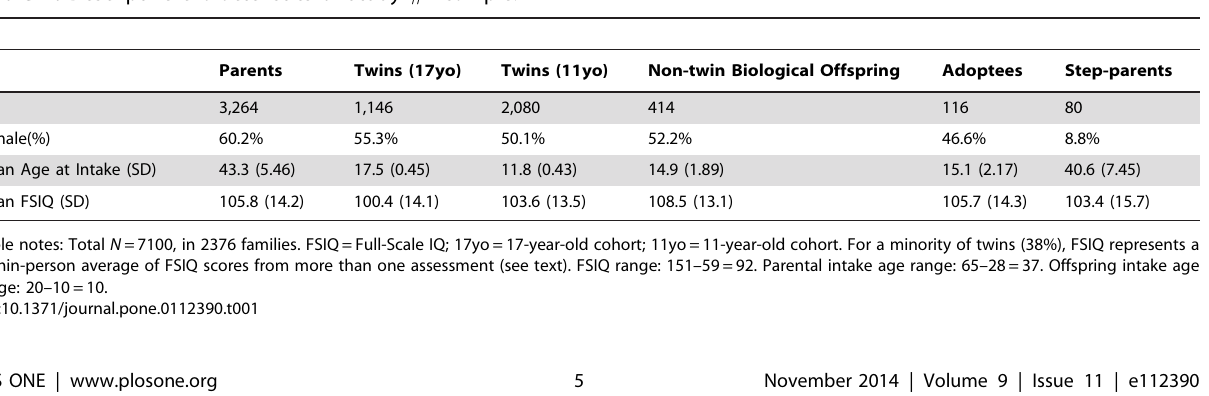
Table 1. Descriptive characteristics of Study # 1 sample.